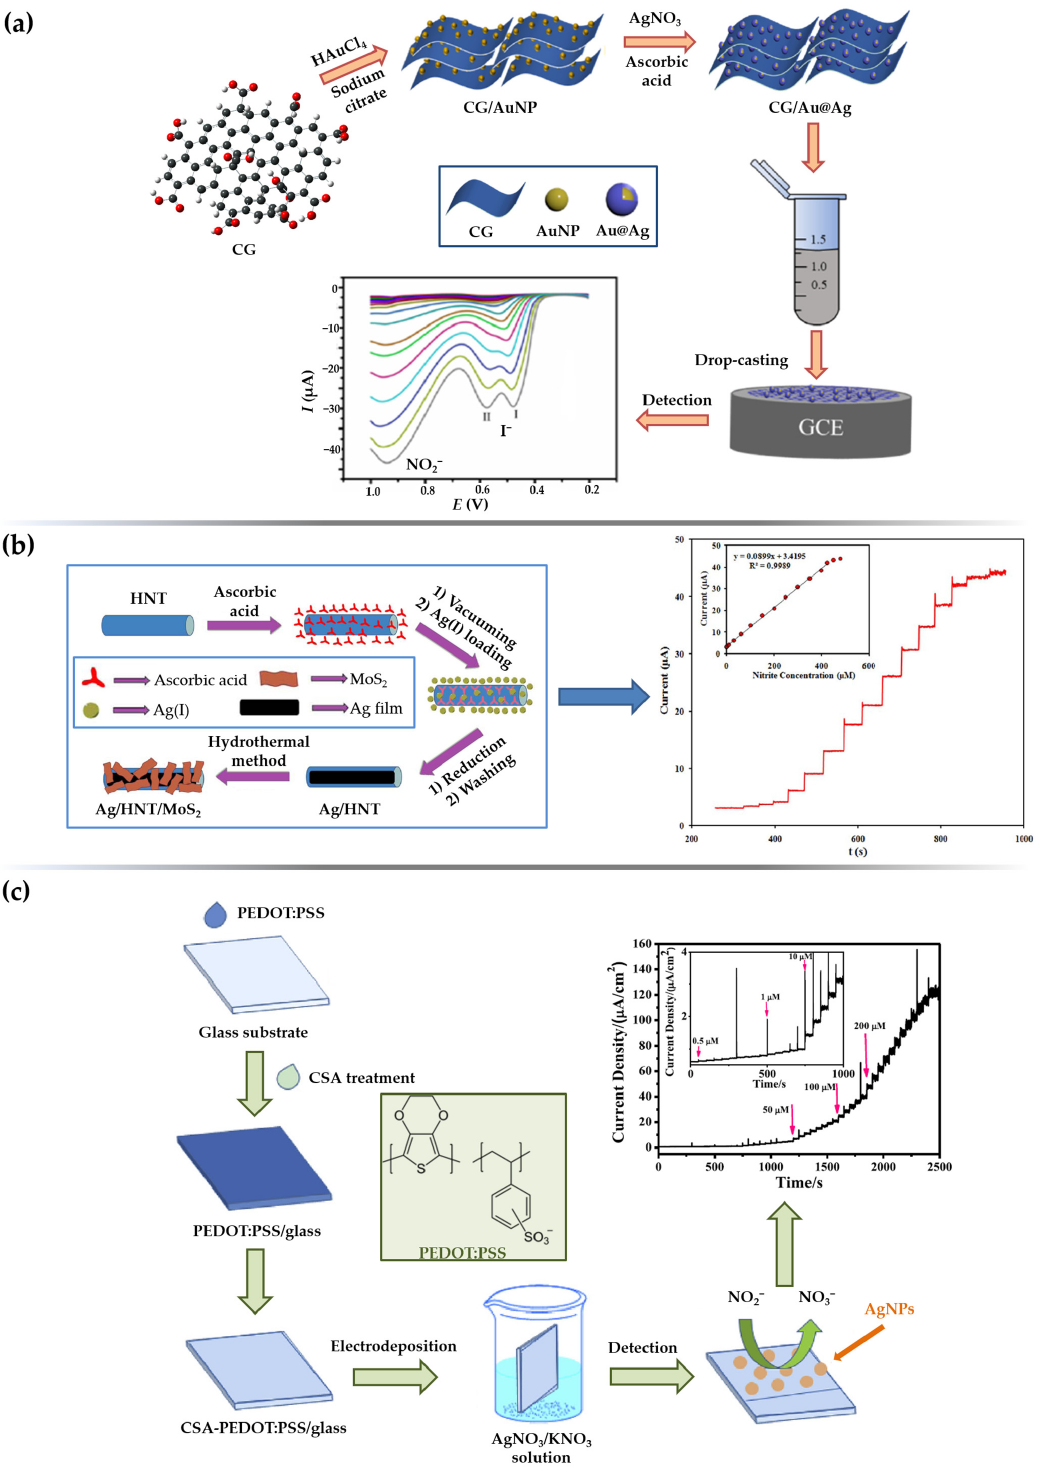
Figure 6. Schematic presentation of selected voltammetric and amperometric sensors for nitrite